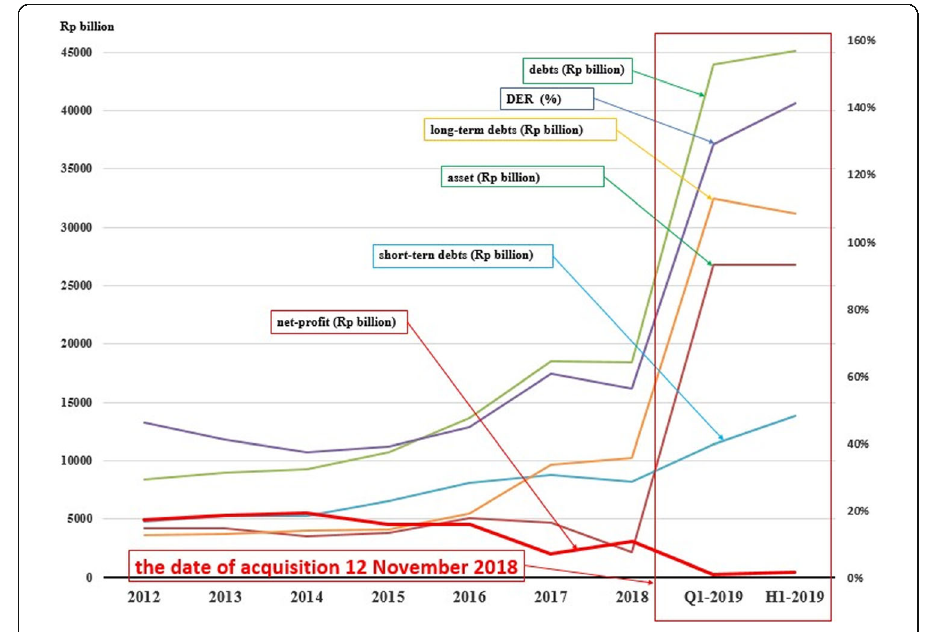
Fig. 1 Financial indicators of SMGR over acquisition of